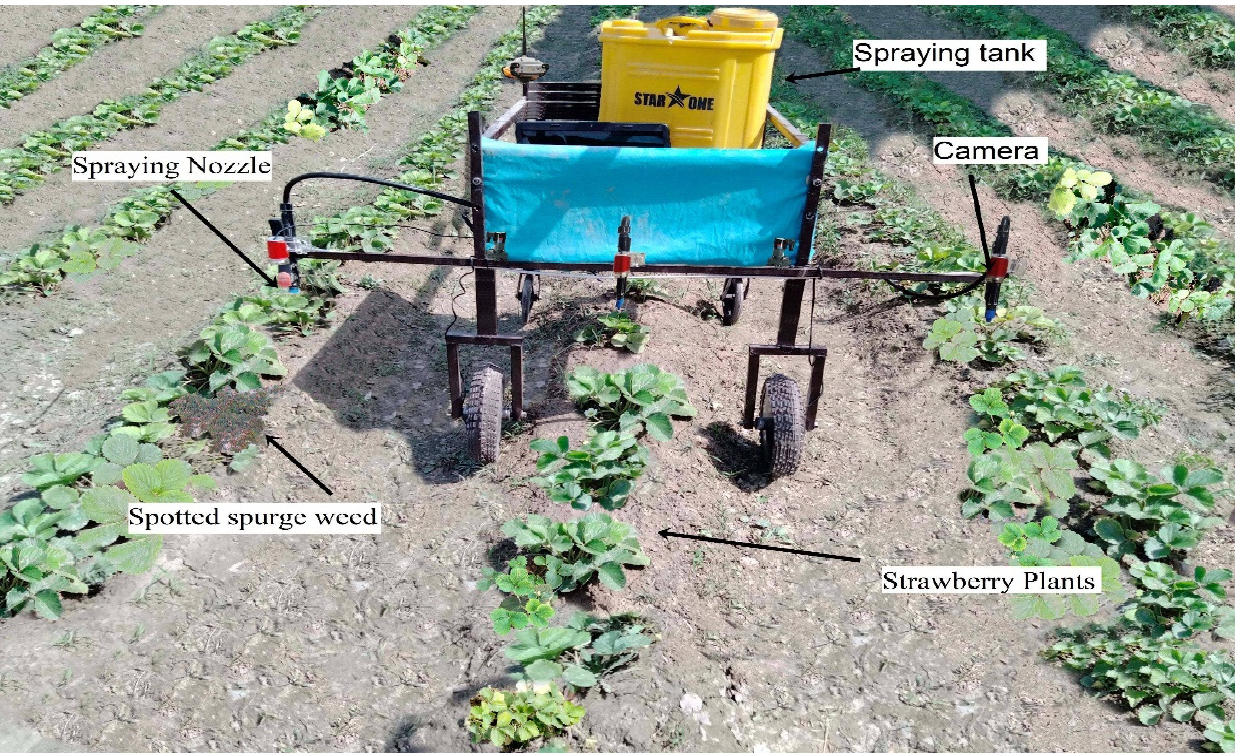
Figure 6. Schematic diagram of variable rate sprayer in field evaluation experiment.